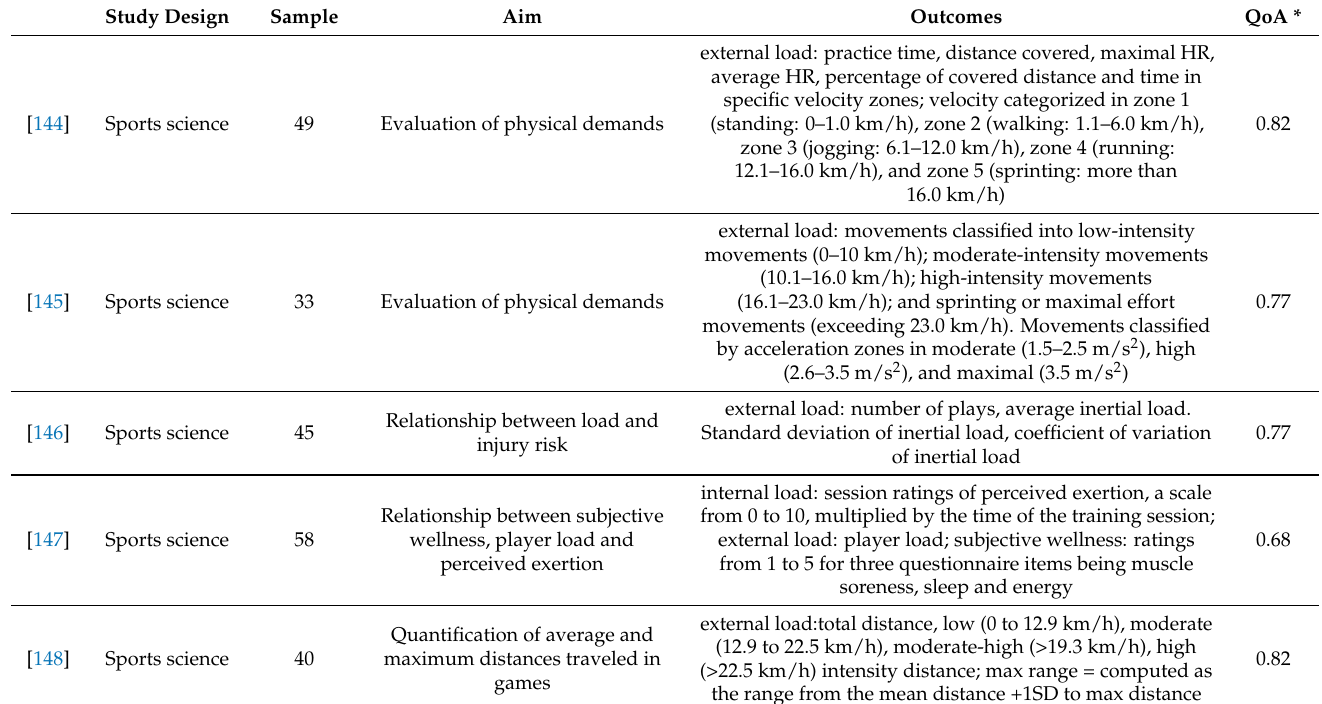
Table 11. Studies regarding